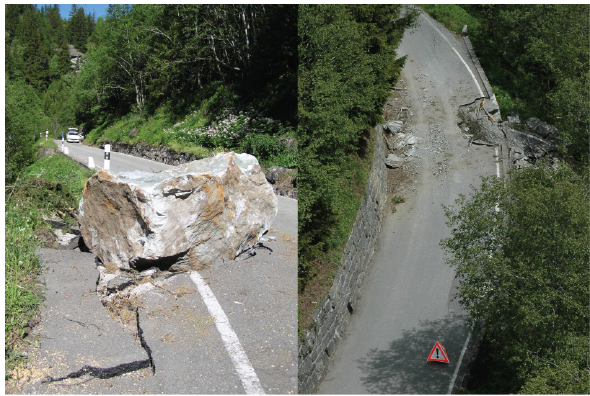
Fig. 1. Photography of a rockfalls event in 2006 that reached twice the road section near Le Plamproz, in the Bagnes Valley. 4